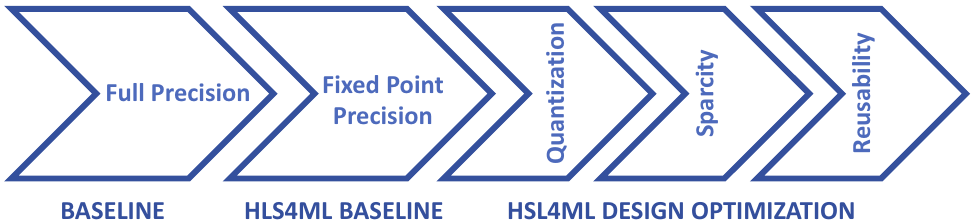
Figure 6. The steps through hls4ml to port a